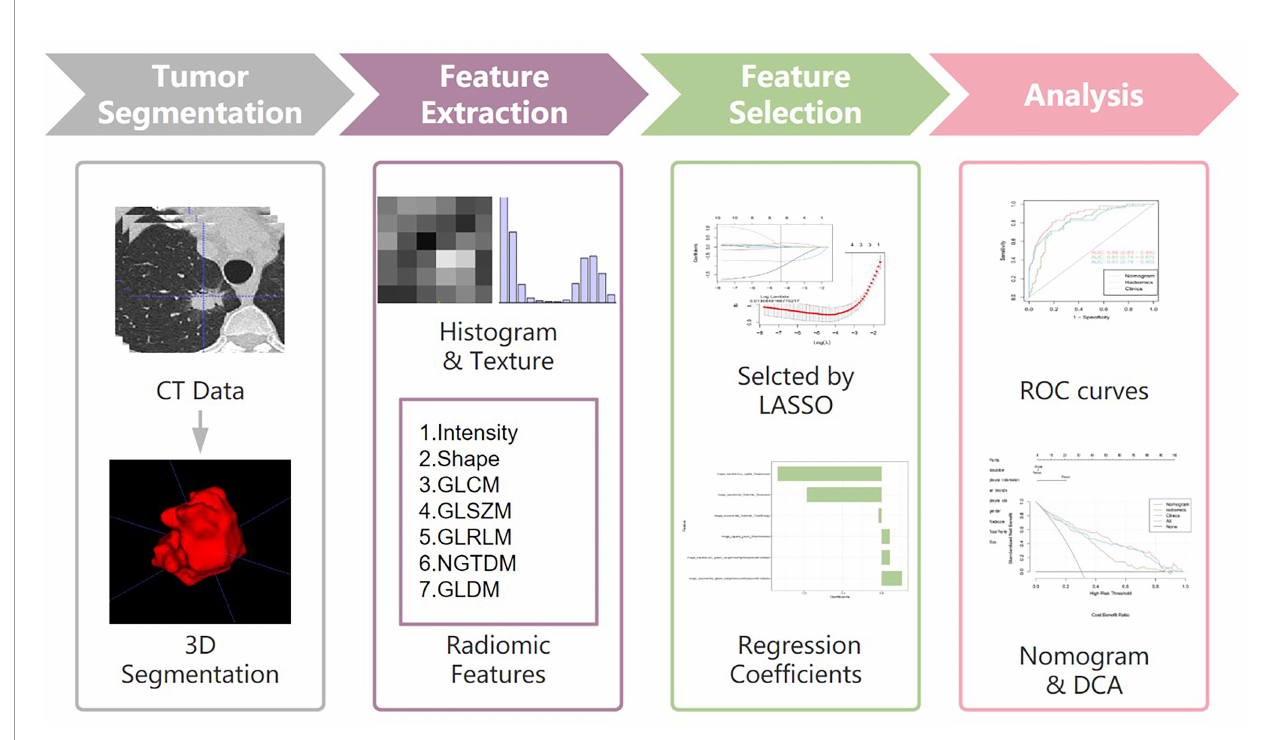
FIGURE 1 | Work fl ow of the study. Work fl ow can be divided into four parts: tumor segmentation, feature extraction, feature selection and